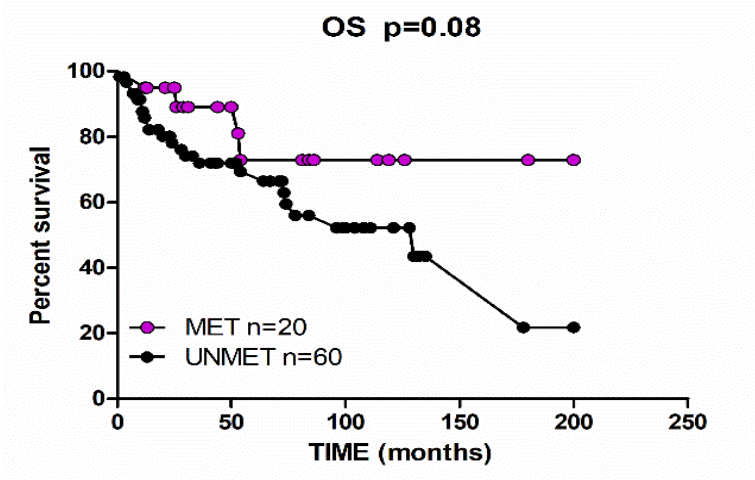
Figure 2. Overall survival at a follow-up time of 200 months, according to BRCA gene methylation status.